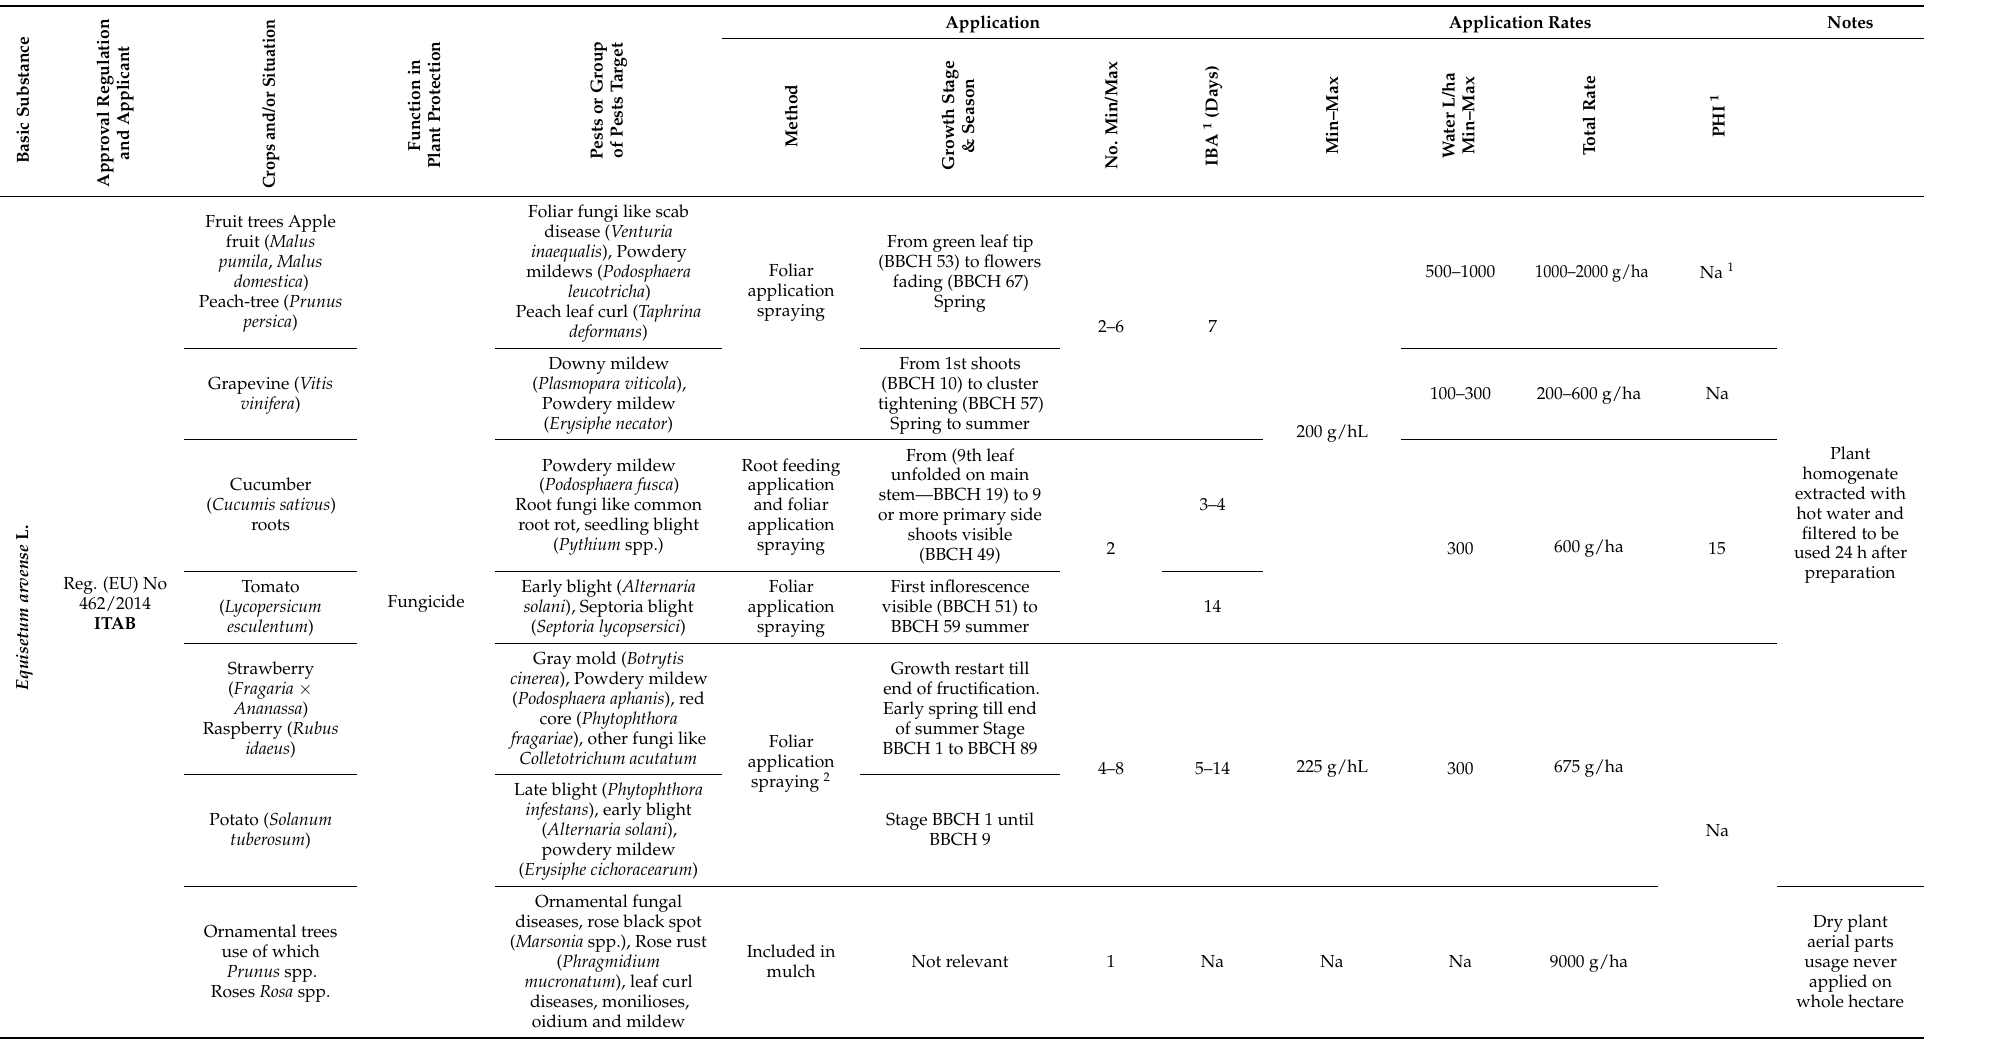
Table 1. Application of the basic substances